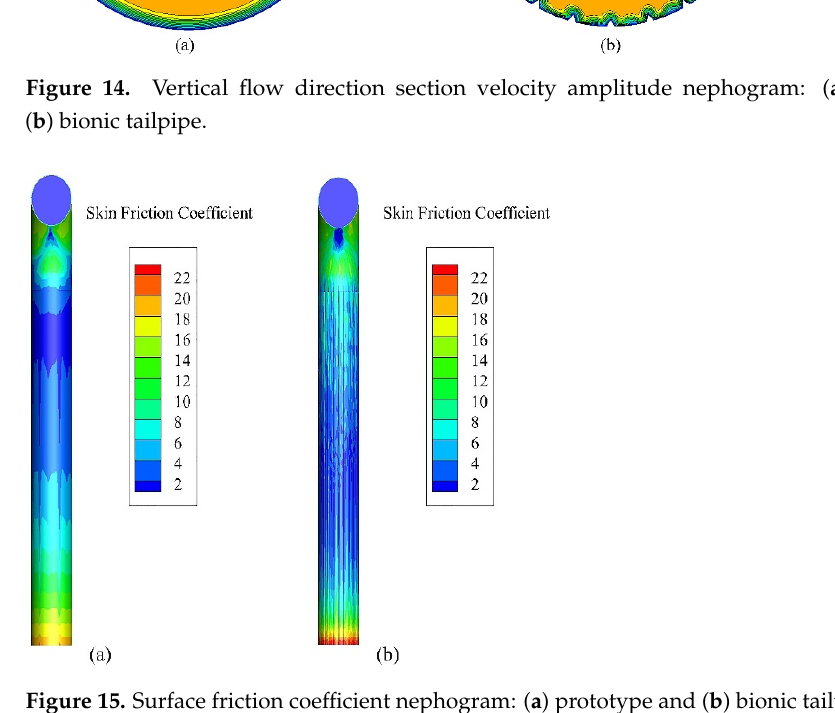
Figure 15. Surface friction coefficient nephogram: ( a ) prototype and ( b ) bionic tailpipe. Table 4. The surface friction coefficient of the tailpipe wall at different inlet velocities. Velocities (m/s)